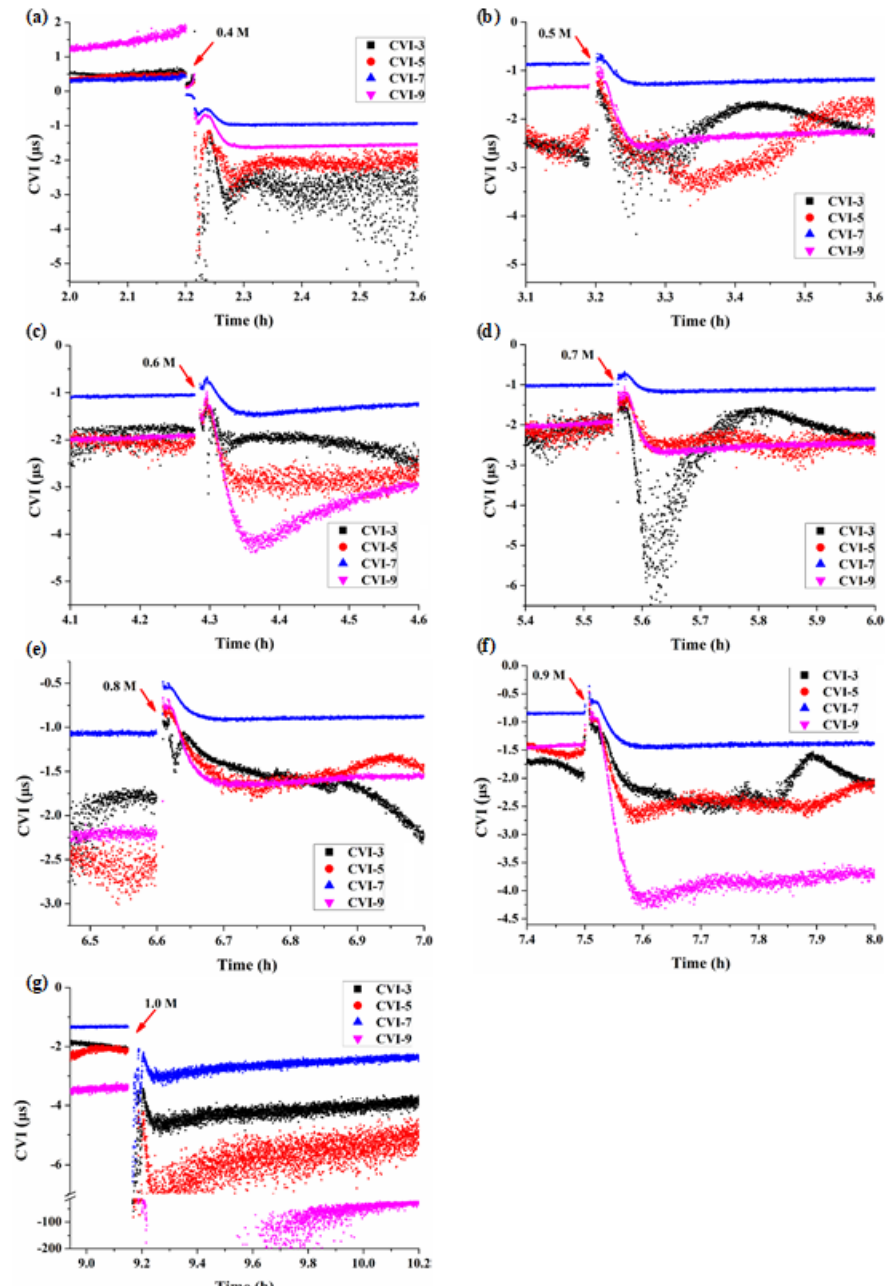
Figure 4. Expanded initial CVI responses of Figure 3c for BY-2 cells subjected to the hypertonic stresses of mannitol concentrations. ( a ) 0.4 M, ( b ) 0.5 M, ( c ) 0.6 M, ( d ) 0.7 M, ( e ) 0.8 M, ( f ) 0.9 M, ( g ) 1.0 M.